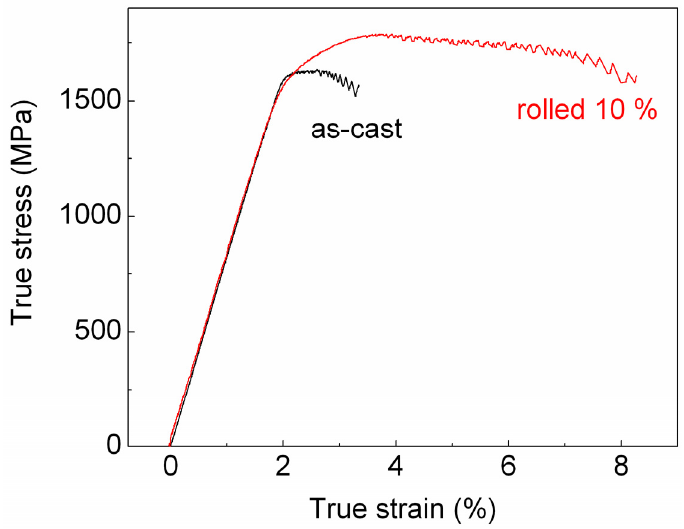
Figure 5. Room temperature stress-strain curves for the as-cast and cold-rolled Zr Ti Cu Ni Al BMG under quasistatic compressive 58.5 8.2 14.2 11.4 7.7